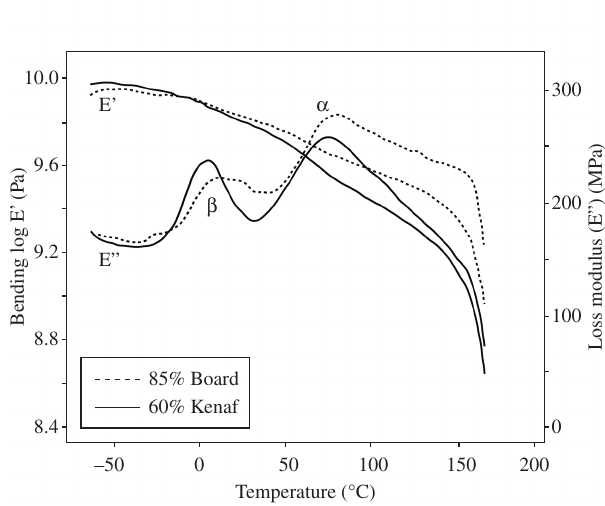
Figure 3. Storage and loss modulus of an 85% fiber filled composite compared to injection molded 60% fiber filled